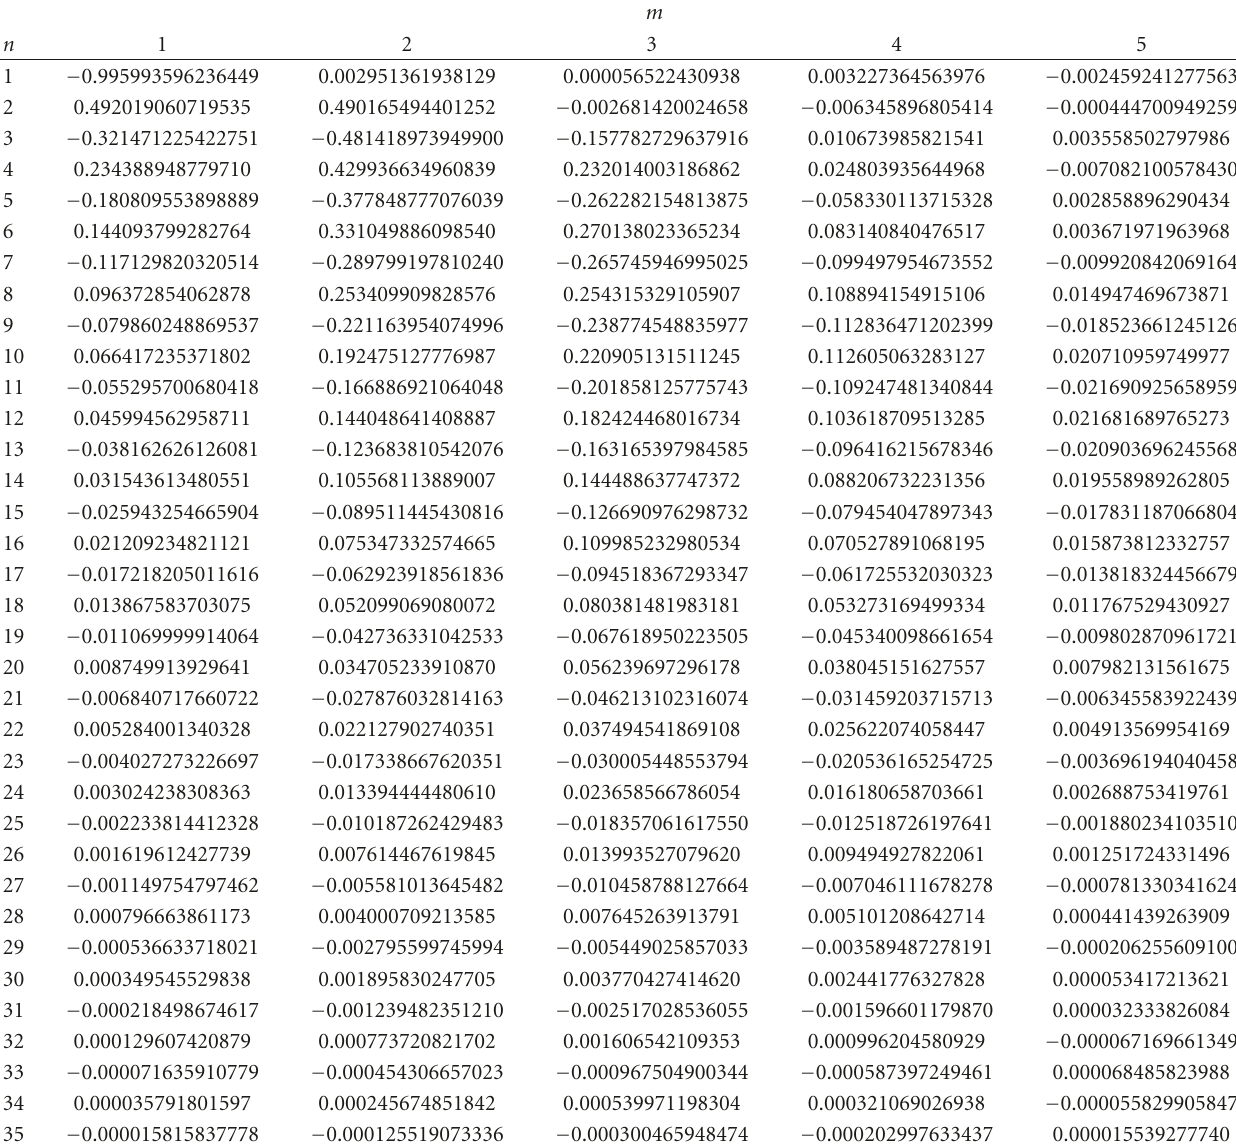
Table 3: Filter coe ffi cients for the proposed minimax design in Example